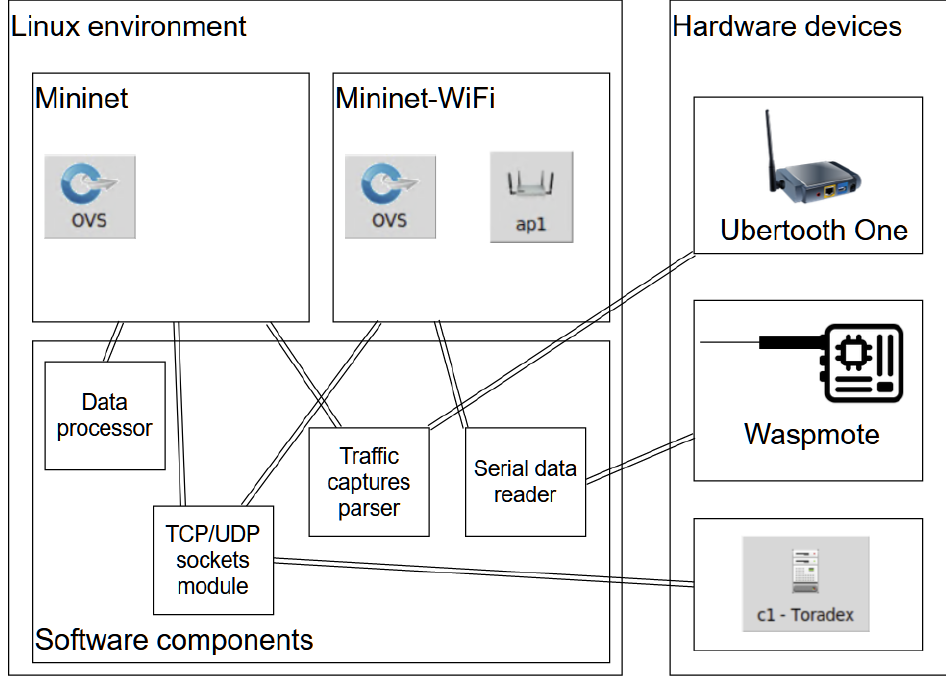
Figure 2. Proposed hybrid system architecture. Components diagram.